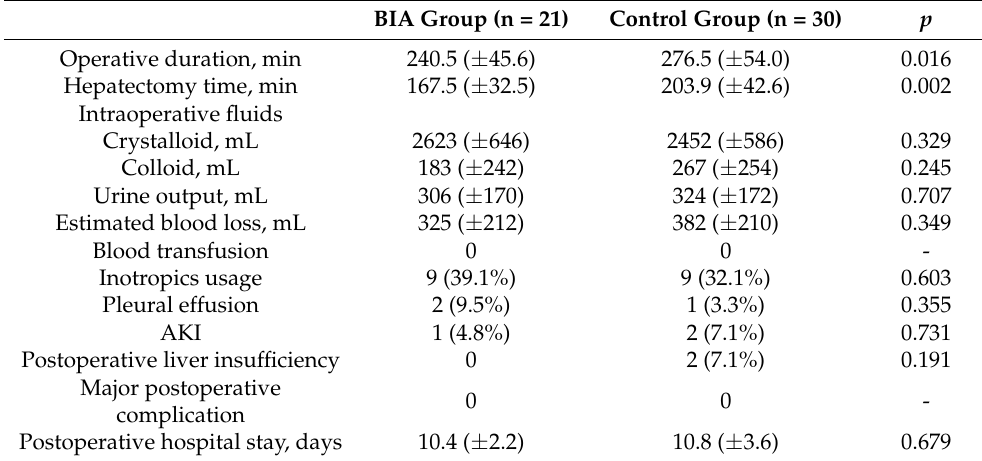
Table 2. Operative outcomes of